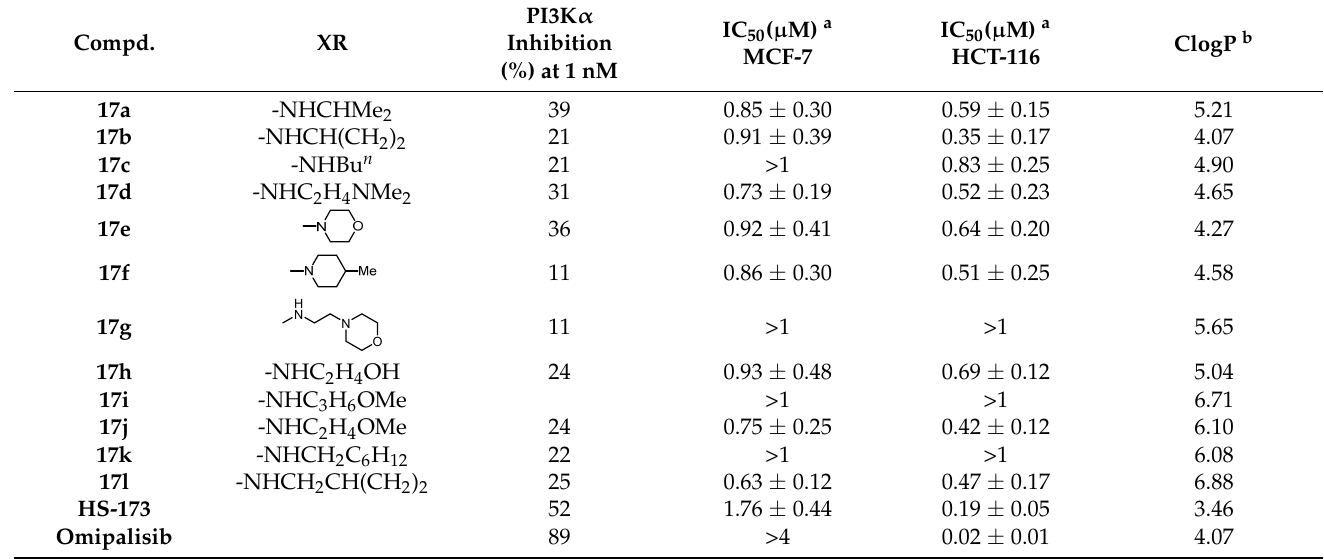
Table 2. Enzyme inhibition of PI3K α and antiproliferative activity against MCF-7 and HCT-116 cells by 17a–l .